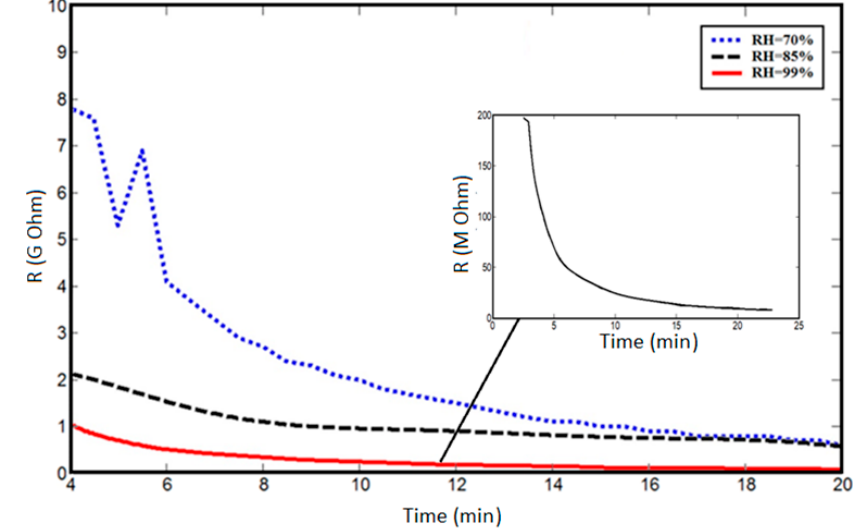
Figure 10. Resistance decay at different RH values (inset graph is the detailed resistance decay at full humidity). In all RH cases, the resistance starts to be saturated after nearly 20 min of continuous exposure to humidity.